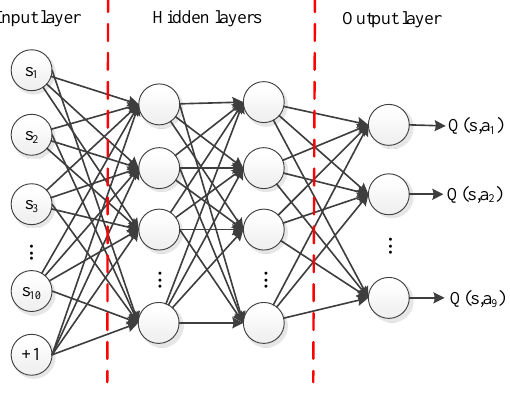
Figure 7. 2D Confrontation Q-Network. Figure 7. 2D Combat Q-Network. Figure 7. 2D Combat Q-Network.